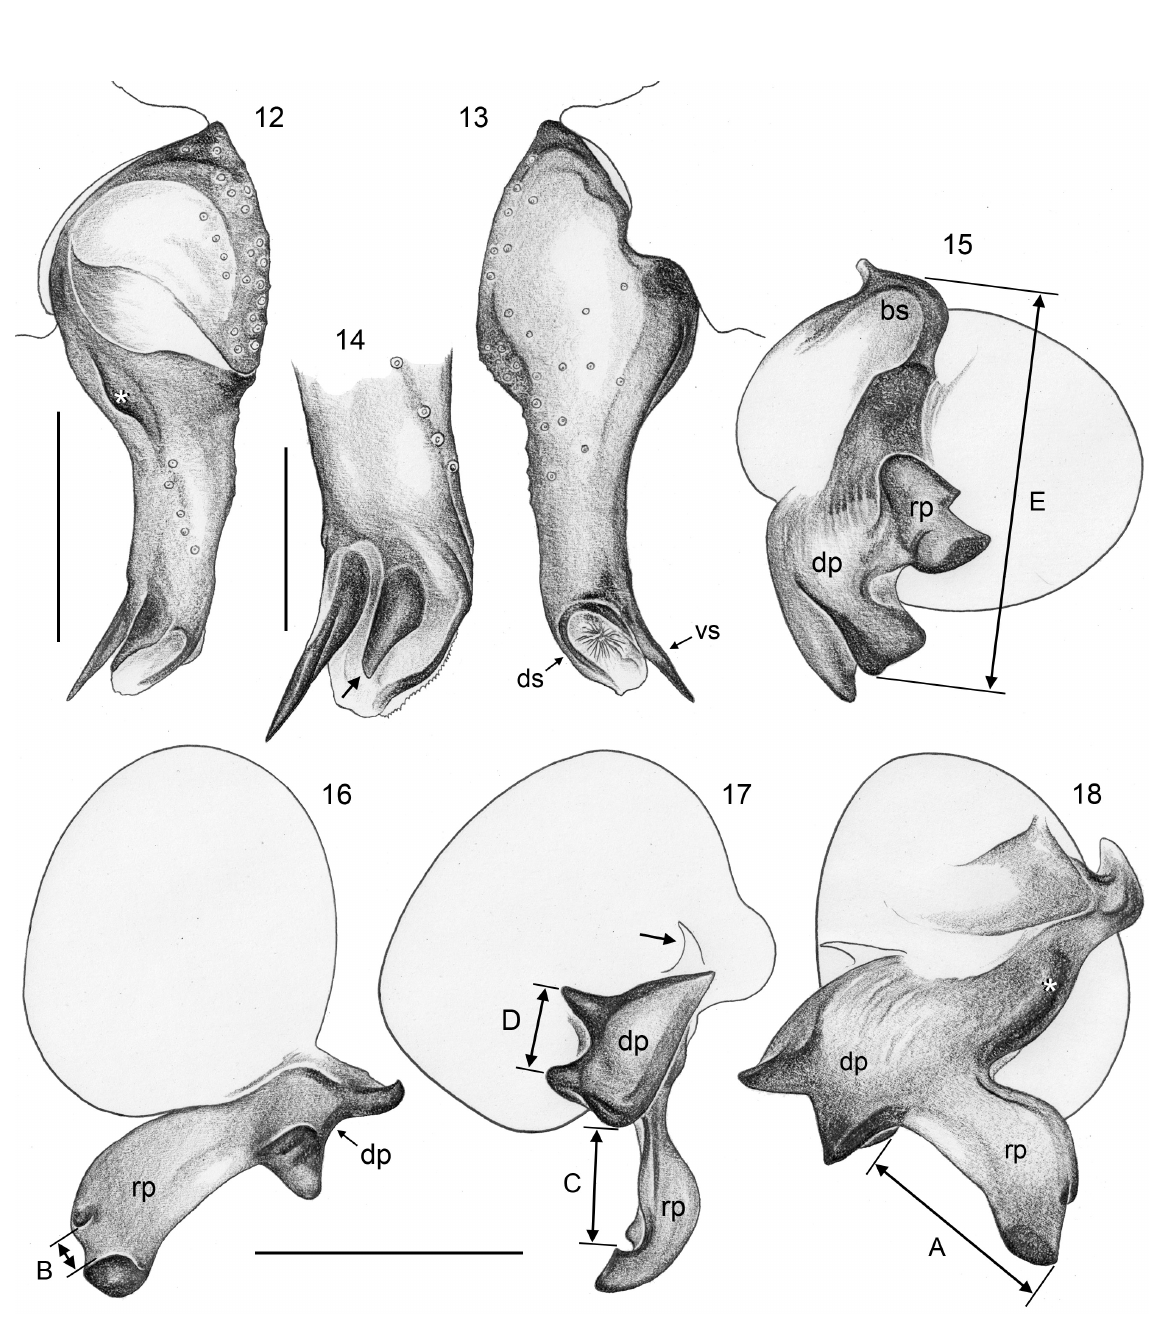
Figs 12–18. Stygopholcus absoloni (Kulczyński, 1914); male from Balićeva špilja, Croatia (ZFMK (Ar 22195)). 12–13 . Left tarsus and procursus, prolateral and retrolateral views; asterisk in Fig. 12 marks prolateral hump. 14 . Tip of left procursus, prolateral (slightly ventral) view; arrow points at distinctive prolateral sclerite. 15–18 . Left genital bulb, retrolateral, ventral, prolateral-distal, and dorso-distal views, showing bulb measures A–E; arrow in Fig. 17 points at transparent bulbal process; asterisk in Fig. 18 marks connecting sclerite that is absent in specimen from Jama na Brezdanu. Abbreviations: bs = basal sclerite; dp = dorsal process; ds = dorsal sclerite; rp = retrolateral process; vs = ventral sclerite. Scale bars: 12–13, 15–18 = 0.5 mm; 14 = 0.25